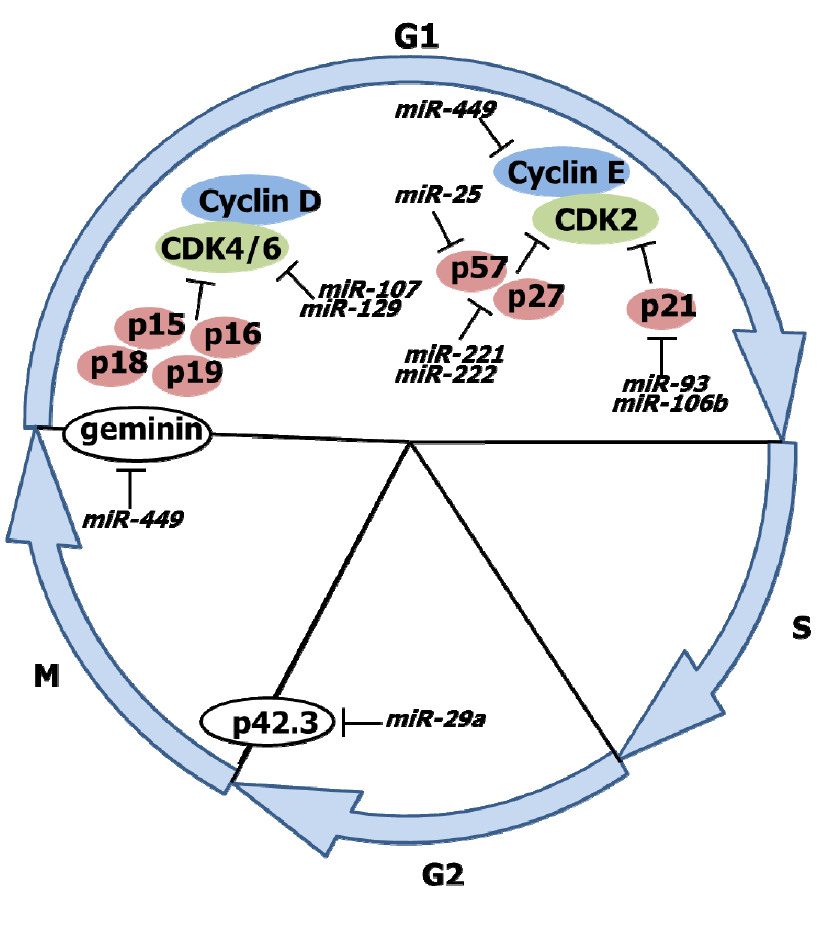
Figure 1. Regulation of cell cycle progression. Cyclins and cyclin-dependent kinases (CDKs) determine a cell’s progress through the cell